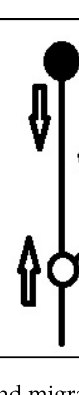
Figure 3. Linear dune defect formation and migration. The dominant wind vector is represented here by the filled arrow, while the migration of the dune defects are represented as open arrows. Transport parallel to crest lines produces downwind migration of defects (terminations: black circles) and upwind migration of Y-junctions (bifurcations: white filled circle) [6].